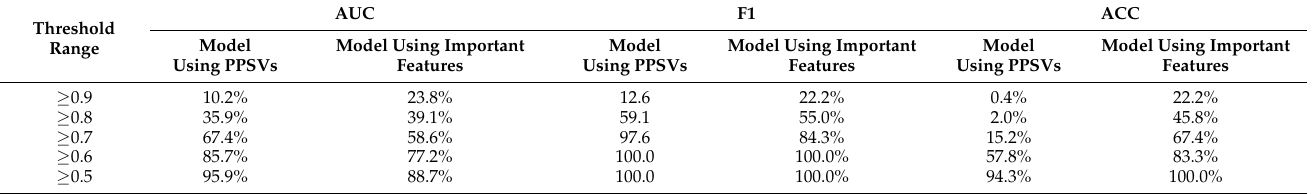
Table 6. Percentage of diseases meeting the indicated performance range for model using PPSVs and important features. AUC F1 ACC Threshold Model Model Using Important Model Model Using Important Model Model Using Important Range Using PPSVs Features Using PPSVs Features Using PPSVs Features ≥